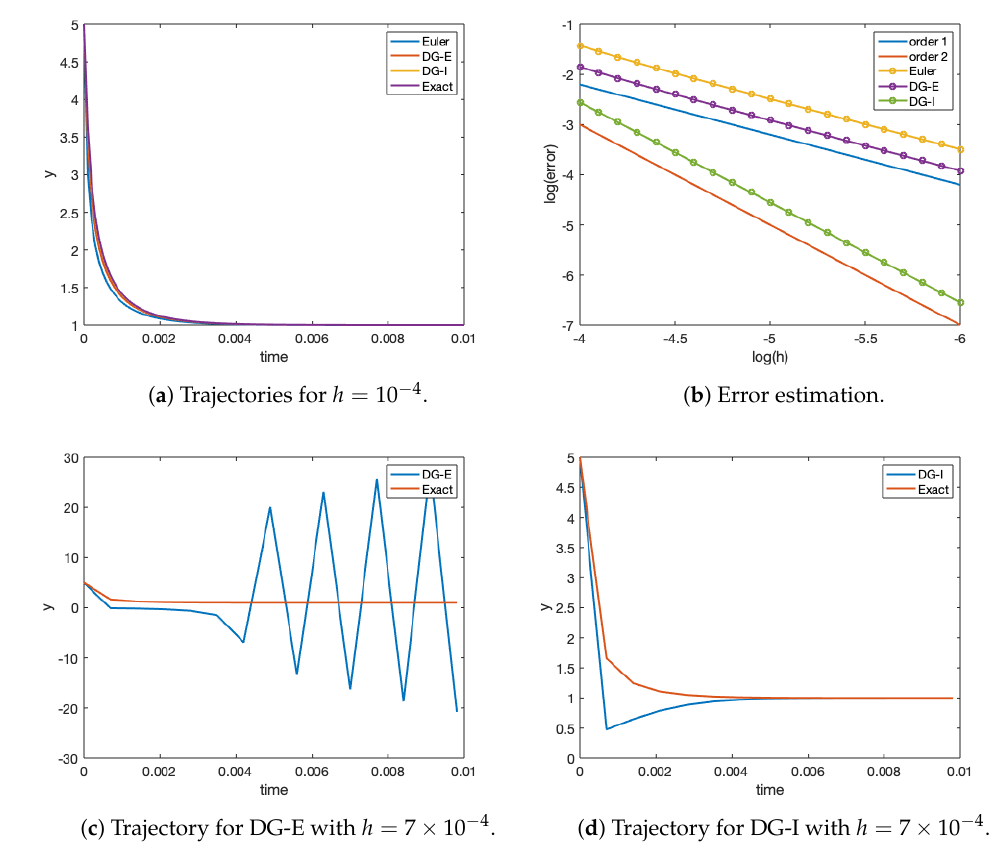
Figure 1. Solutions for the logistic equation obtained by the Euler method, the explicit method in Equation (23) (DG-E), the implicit method in Equation (27) (DG-I), and the exact